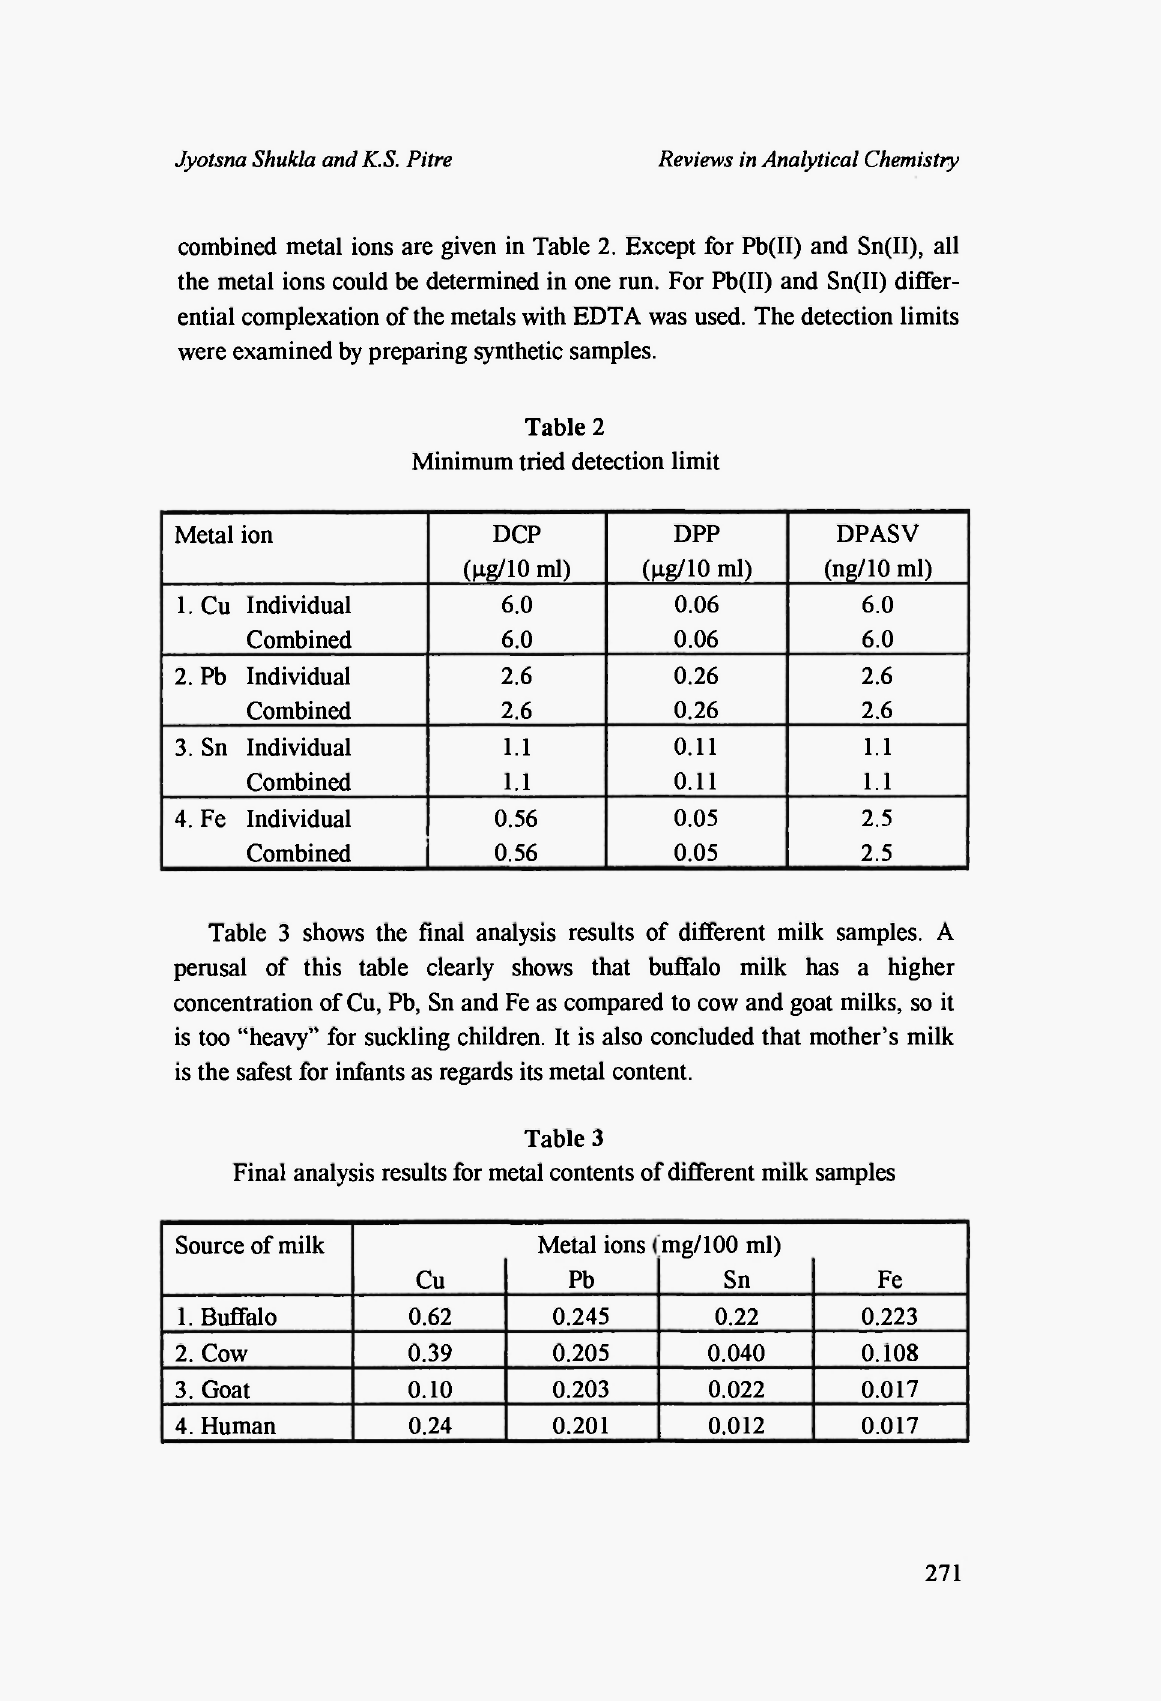
combined metal ions are given in Table 2. Except for Pb(II) and Sn(II), all the metal ions could be determined in one run. For Pb(II) and Sn(II) differ- ential complexation of the metals with EDTA was used. The detection limits were examined by preparing synthetic samples.